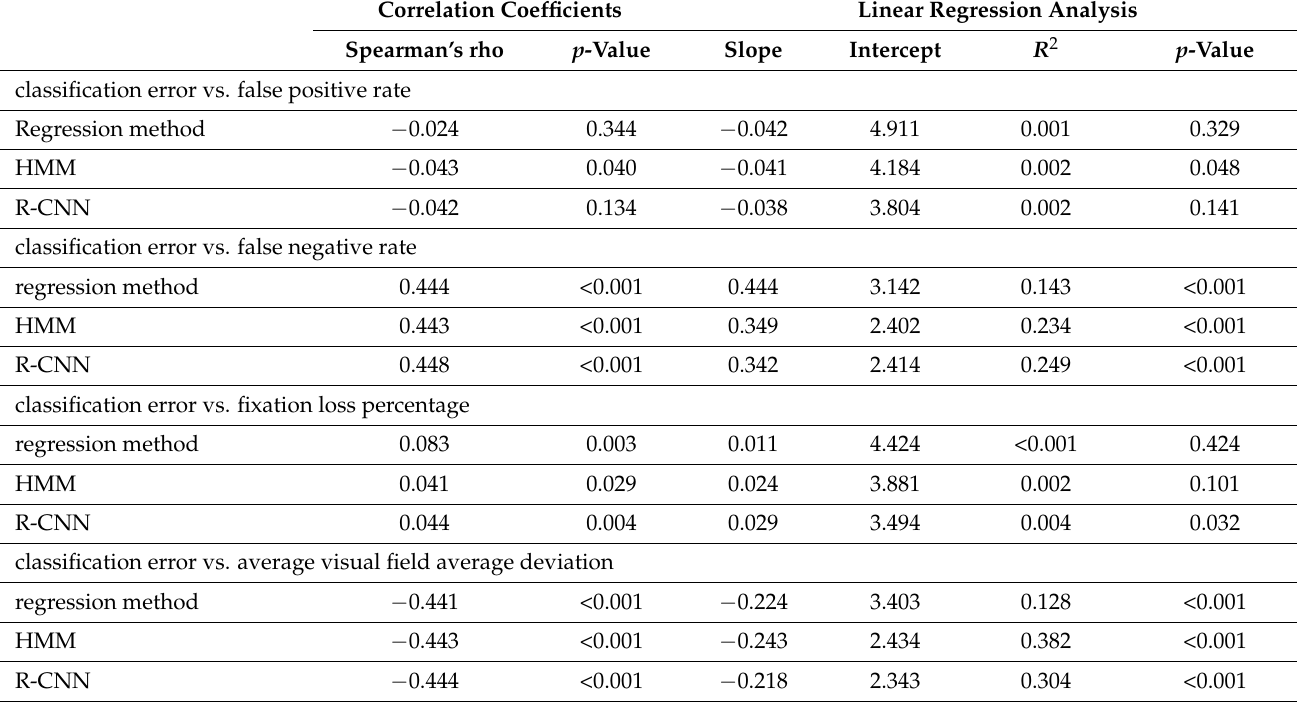
Table 12. Correlation coefficients and linear regression analyses between classification error and reliability and between classification error and visual field average